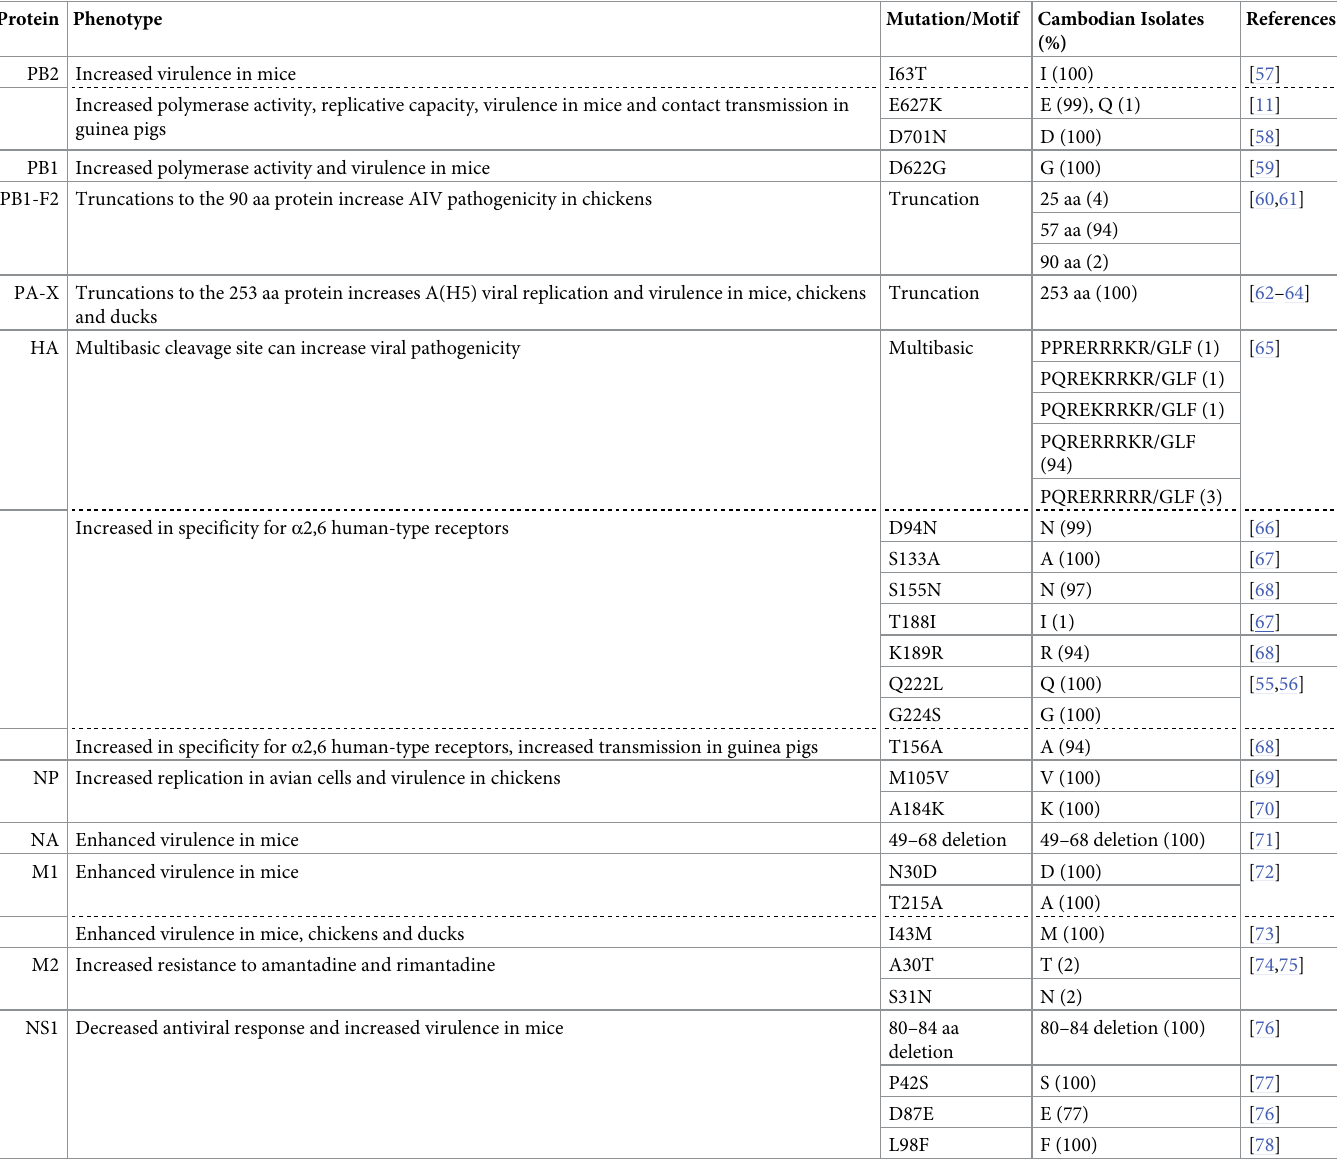
Table 1. Summary of amino acid substitutions in Cambodian A(H5N1) viruses associated with changes in viral fitness. Protein Phenotype Mutation/Motif Cambodian Isolates